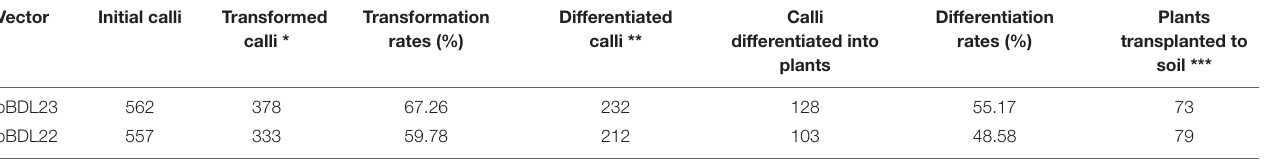
FIGURE 2 | Rice calli transformed with fluorescent protein-expressing Ac/Ds transposon vectors. (A) Rice calli were co-cultivated with Agrobacterium carrying the double-fluorescent protein-expressing Ac/Ds transposon vector pBDL23, and then were selected on hygromycin medium for 19 days. Hygromycin-resistant (Hyg+) calli were picked up for a second-round selection for 20 days and assayed for GFP and mCherry fluorescence. (B) pBDL22 derived from the single-fluorescent protein-expressing Ac/Ds transposon vector pLJ26 (Gao et al., 2015) was transformed into rice in parallel control experiments. TABLE 1 | Transformation and differentiation rates of pBDL23- and pBDL22-transformed rice calli.